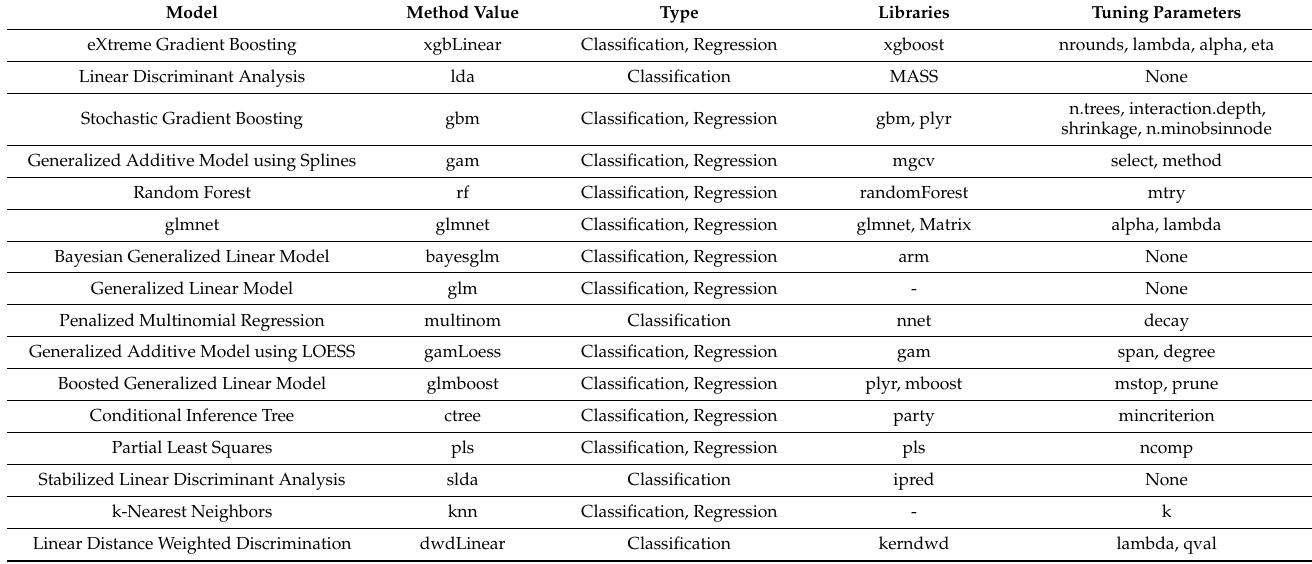
Table A1. Models of the Caret package used for machine learning in this